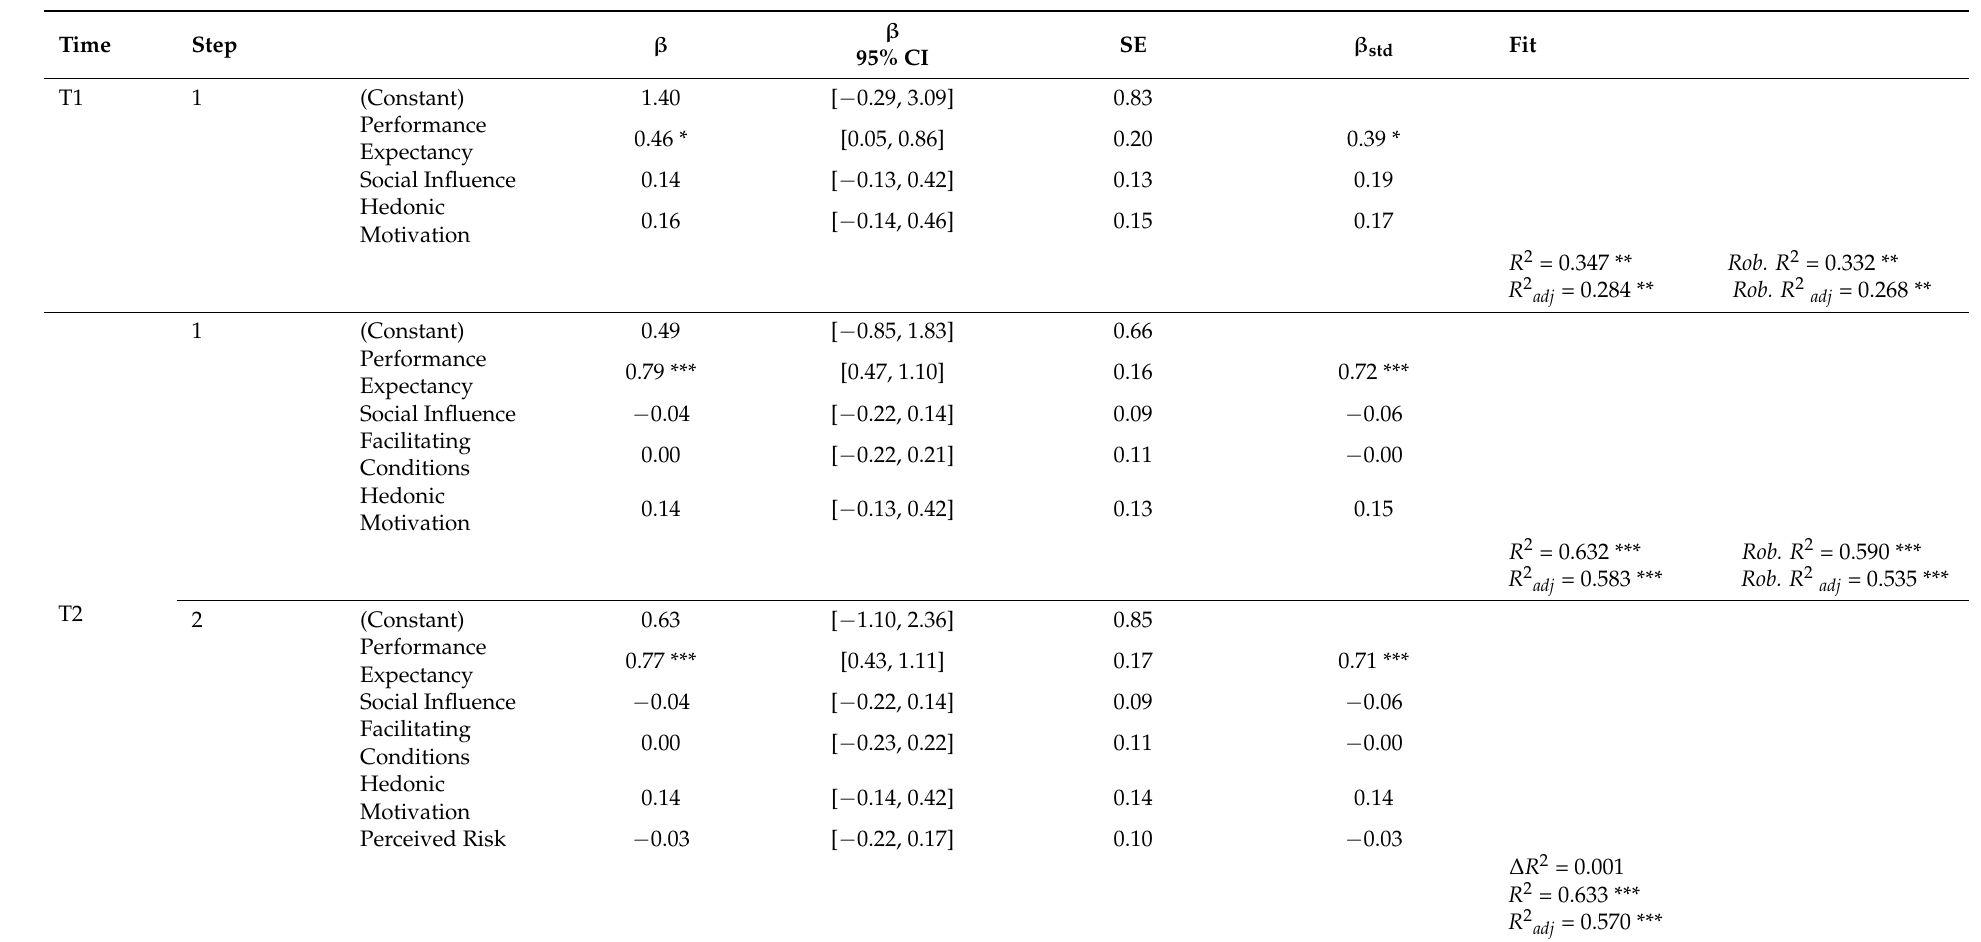
Table 3. Results of the hierarchical MLRs at T1, T2 and